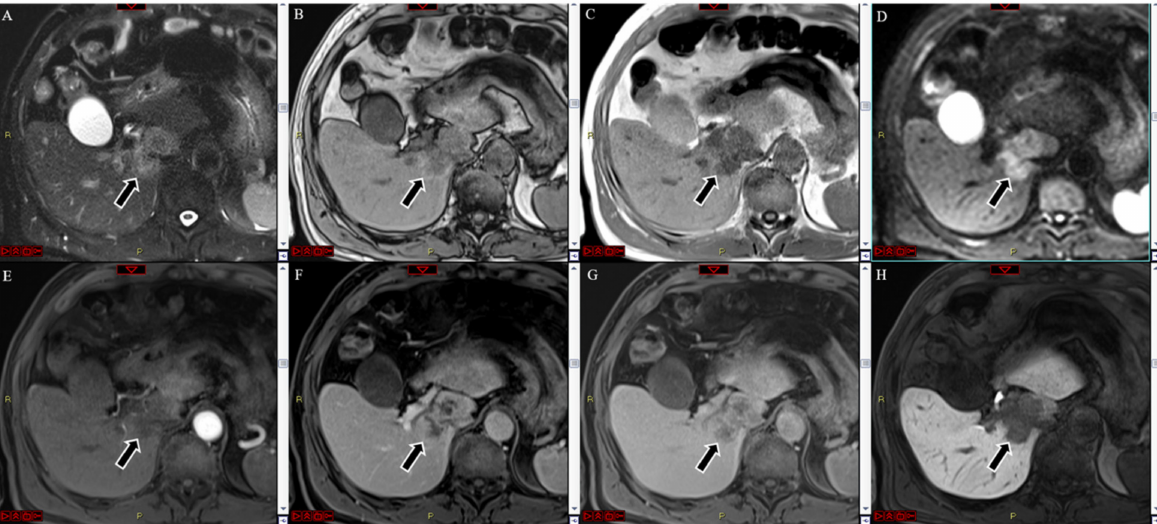
Figure 1. MRI with Gd-EOB-DTPA of a histologically confirmed intra-hepatic cholangiocarcinoma located in the segment I of the liver (arrow). The lesion showed hyperintensity at the T2-weighted image ( A ), whereas it was hypo both in in- and out-of-phase T1-weighted images ( B , C ), coupled with strong hyperintensity in the diffusion-weighted image ( D ). No significant hyperenhancement was seen in the arterial phase ( E ). A heterogeneous centripetal enhancement was detected during the portal and late venous phases ( F , G ), without any washout, but the center of the lesion was continuously hypointense. In the hepatobiliary phase, the lesion appeared hypointense ( H